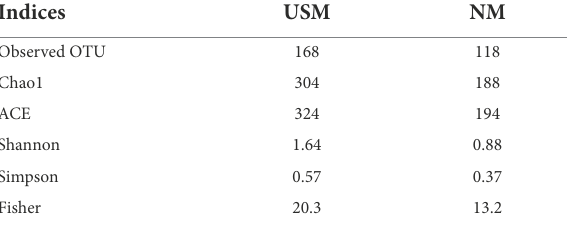
TABLE 2 The alpha diversities of each sample identified by metataxonomic